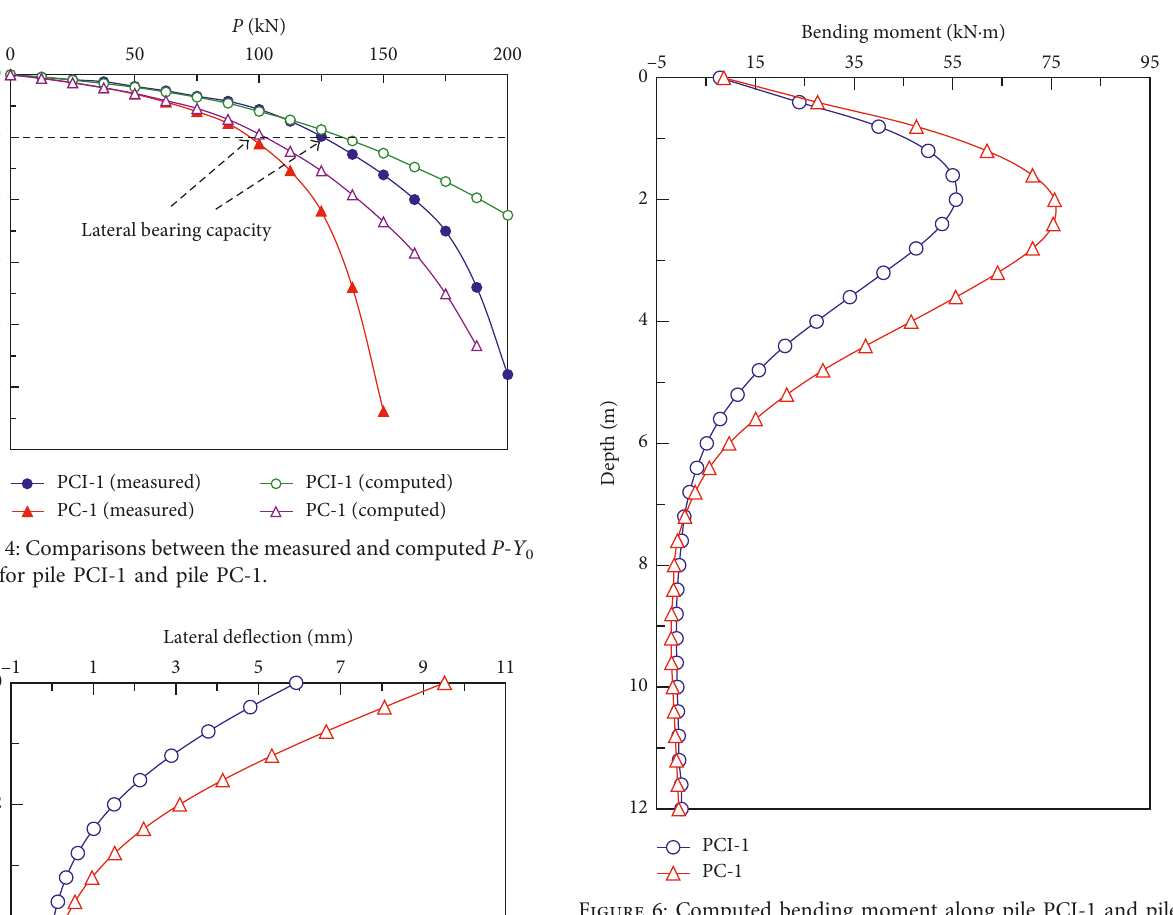
Figure 6: Computed bending moment along pile PCI-1 and pile PC-1 at a lateral load of